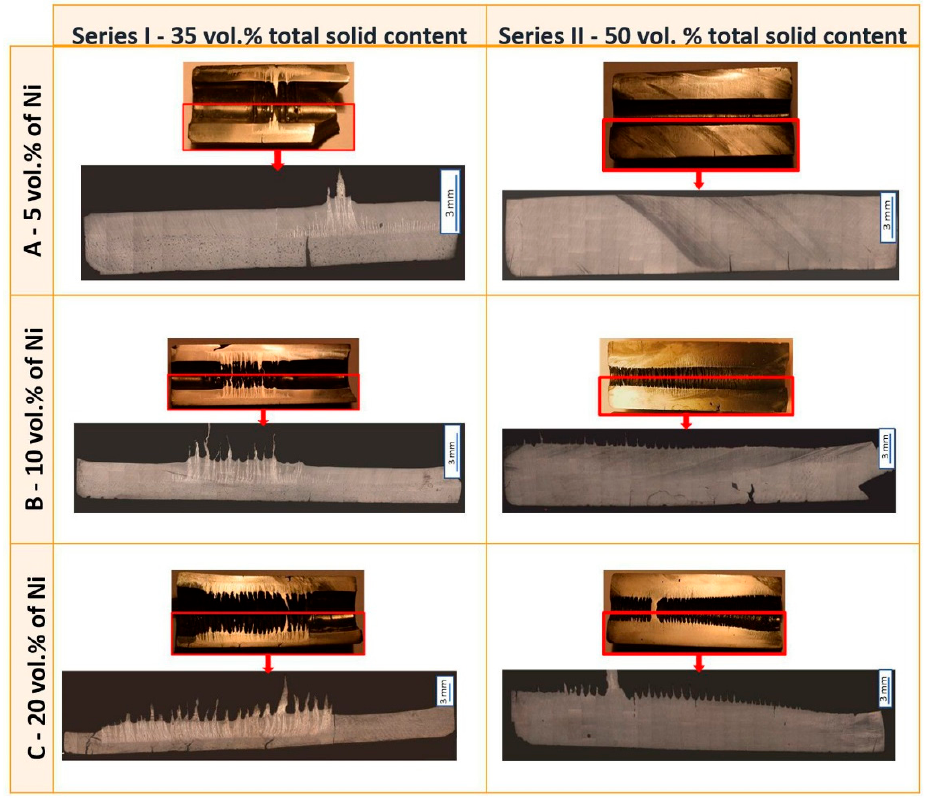
arranged in the direction of the magnetic field can be distinguished.